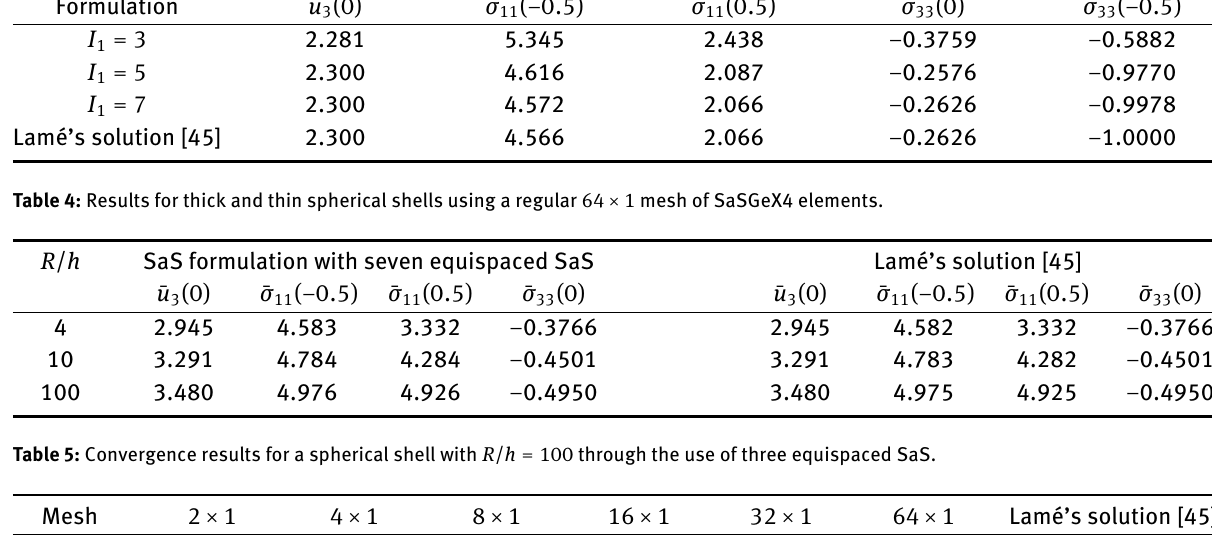
Figure 7: Convergence study due to mesh refinement for a simply supported three-layer rectangular plate with I n = 5; reference displace- ments and stresses are provided by the exact solution based on the SaS formulation [4]. Table 3: Results for a spherical shell with R / h = 2 using a regular 64 × 1 mesh of SaSGeX4 elements. Formulation